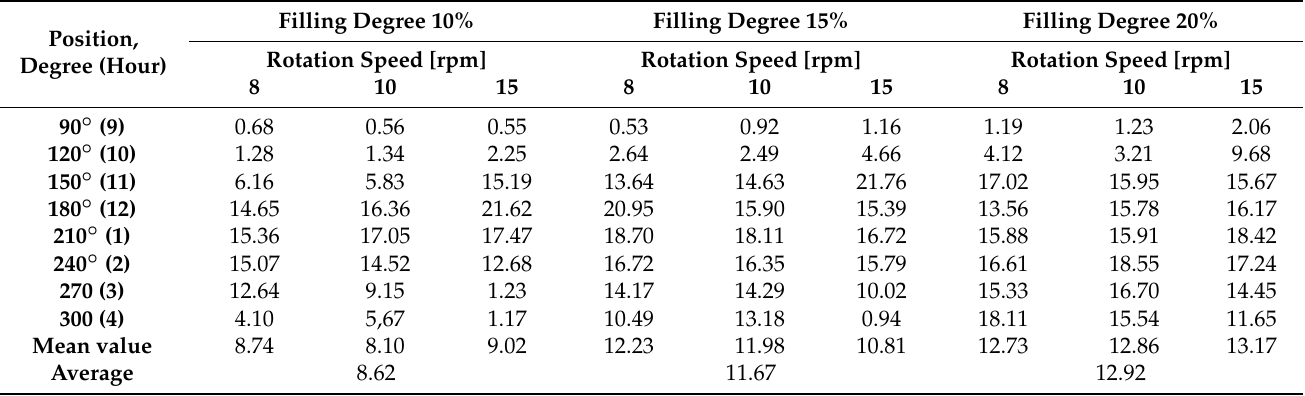
Table 3. The percentage of the area occupied by the particles ( AOR %) for cup-type